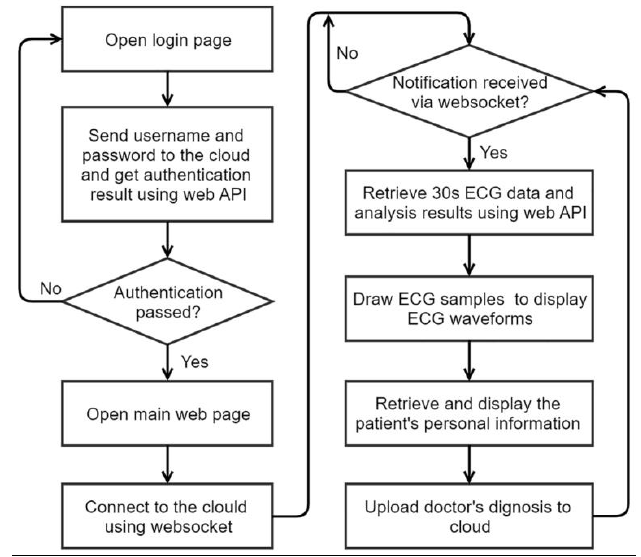
Figure 8. Flow chart of the web application of ECG diagnosis.